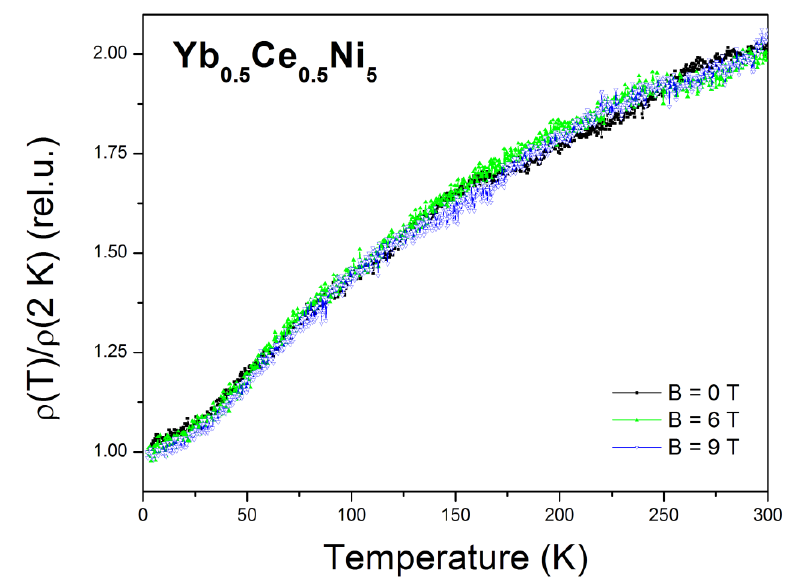
Figure 5. Electrical resistivity of Yb 0.5 Ce 0.5 Ni 5 compound in different applied magnetic fields of 0–9 T (normalized to 2 K).